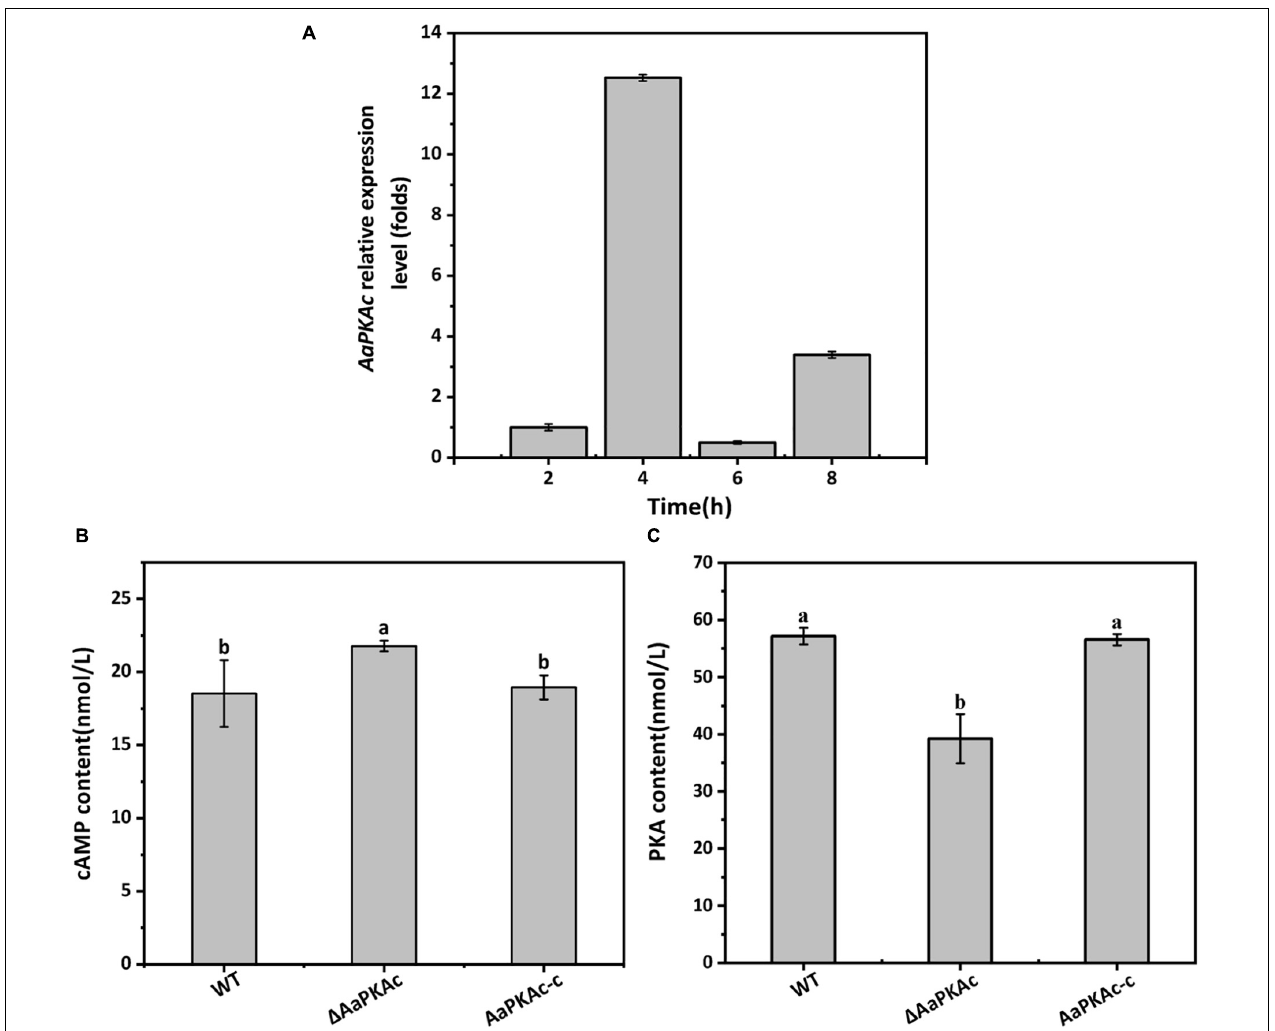
FIGURE 1 | The gene expression of AaPKAc on the hydrophobic surface at the spore germination (2 h), appressorium formation (4 h), bud tube elongation (6 h), and infection hyphae formation (8 h) stage (A) . GAPDH was used as an internal control; three replicates were performed for each sample. Intracellular cAMP (B) and PKA (C) contents of the wild-type strain (WT), the (cid:49) AaPKAc mutant, and AaPKAc genetic complementation strain (AaPKAc-c) were analyzed. Mycelia were harvested after 7 days of incubation on PDA. Vertical lines indicate standard error ( ± SE); different letters indicate significant differences among treatments ( P < 0.05). TABLE 1 | Hydrophobicity of the gelbond hydrophobic membrane coated with different contents of pingguo pear wax extract. Treatment